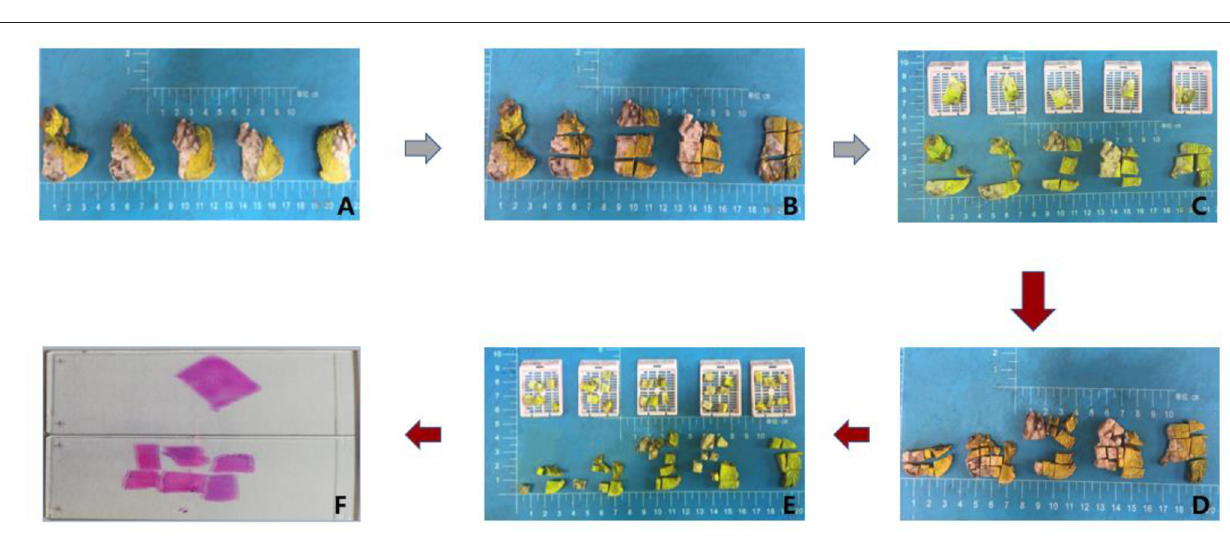
FIGURE 2 | Workflow of tumour sampling. First routine sampling (A,B,C,F) and then multi-site tumour sampling (A–F)